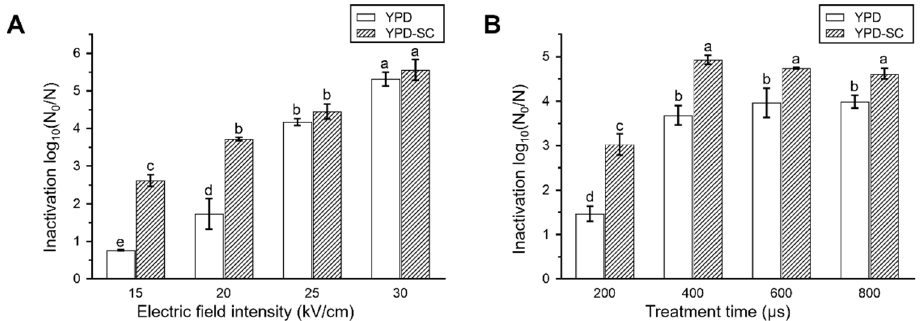
Figure 1. Effects of different electric field intensity ( A ) and treatment time ( B ) of PEF on inactivation and sublethal injury of S. cerevisiae . YPD, non-selective medium; YPD-SC, selective medium. Data are expressed as mean ± standard deviation. Significant differences are indicated by different letters ( p < 0.05).